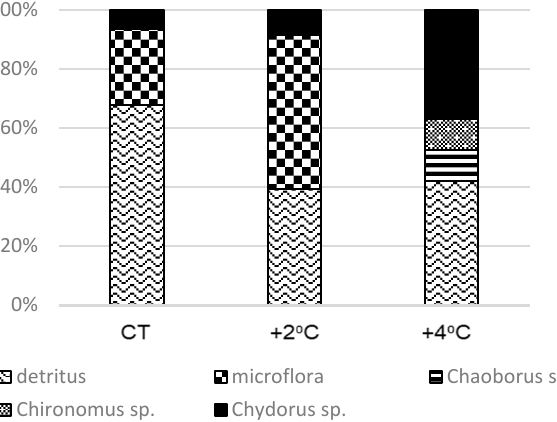
Figure 5. An abundance of biomass (%P) of types of food in the contents of A. nebulosus digestive tracts in treatments with fish, CT—control treatments, +2 °C—treatment with temperature increased by +2 °C relative to the control, +4 °C—treatment with temperature increased by +4 °C relative to the control.